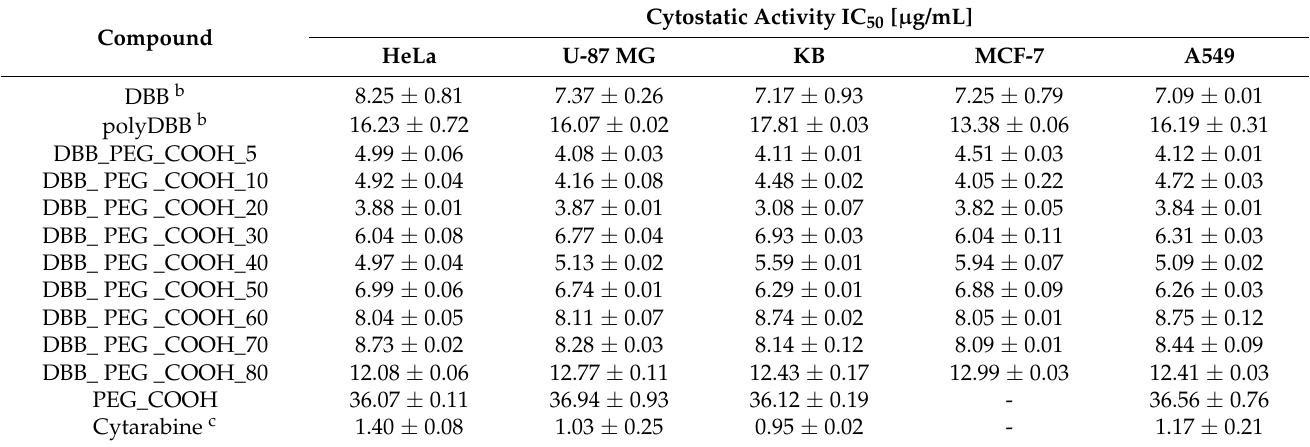
Table 2. Cytostatic activity of polyanhydrides against various cancer cell lines, expressed as IC 50 a .